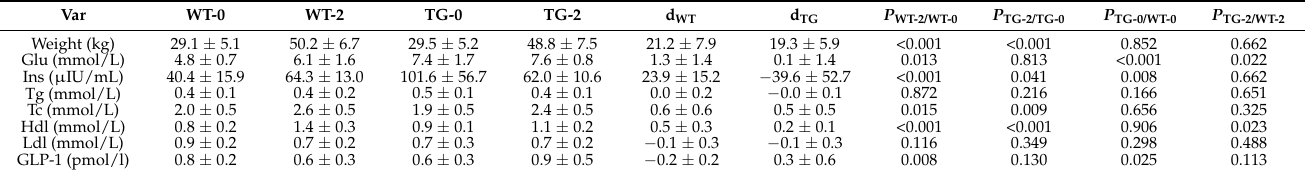
Table 1. The body weight and plasma biochemical parameters of wild-type and PIGinH11 pigs at the baseline and after HFHSD